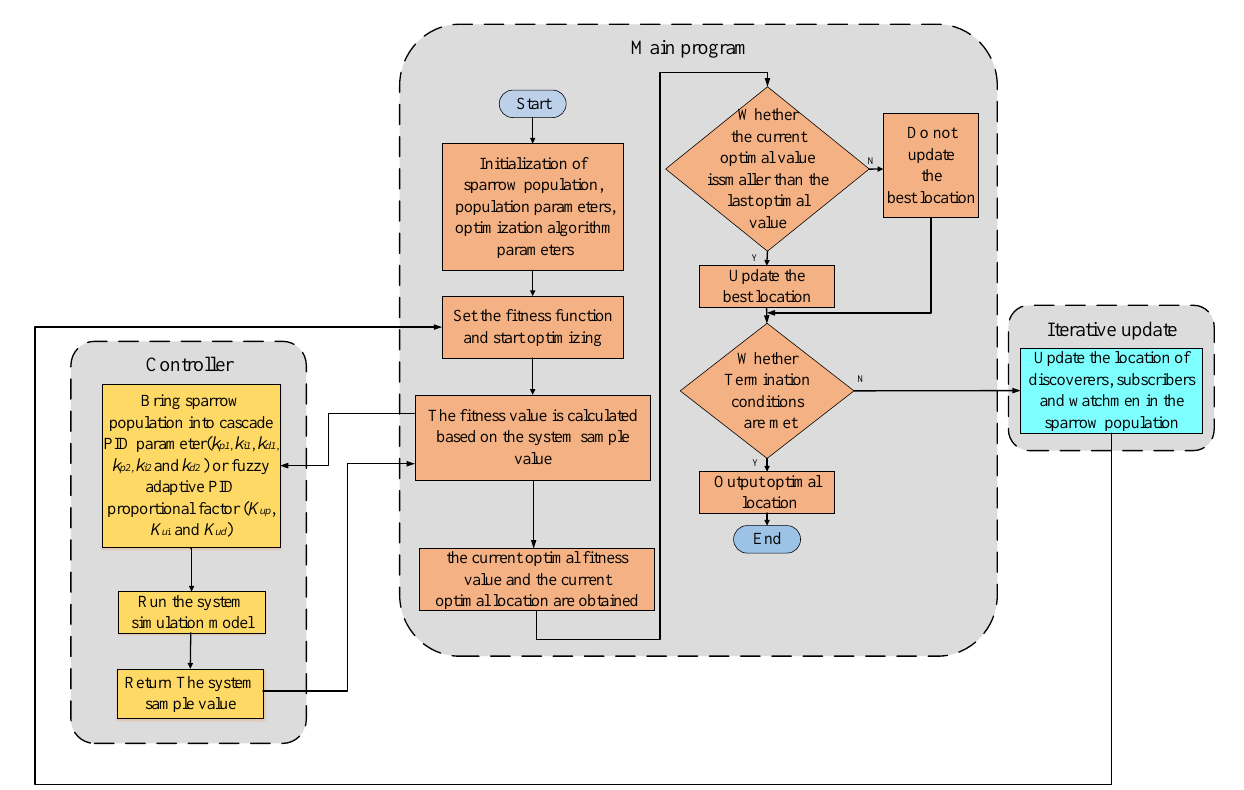
Figure 7. Flow chart of the controller parameters optimized using SSA. Figure 8a exhibits the comparison among SSA — the moth flame optimization